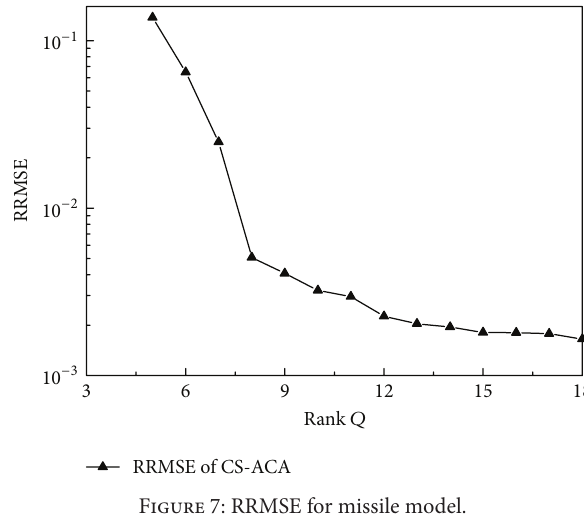
Figure 7: RRMSE for missile